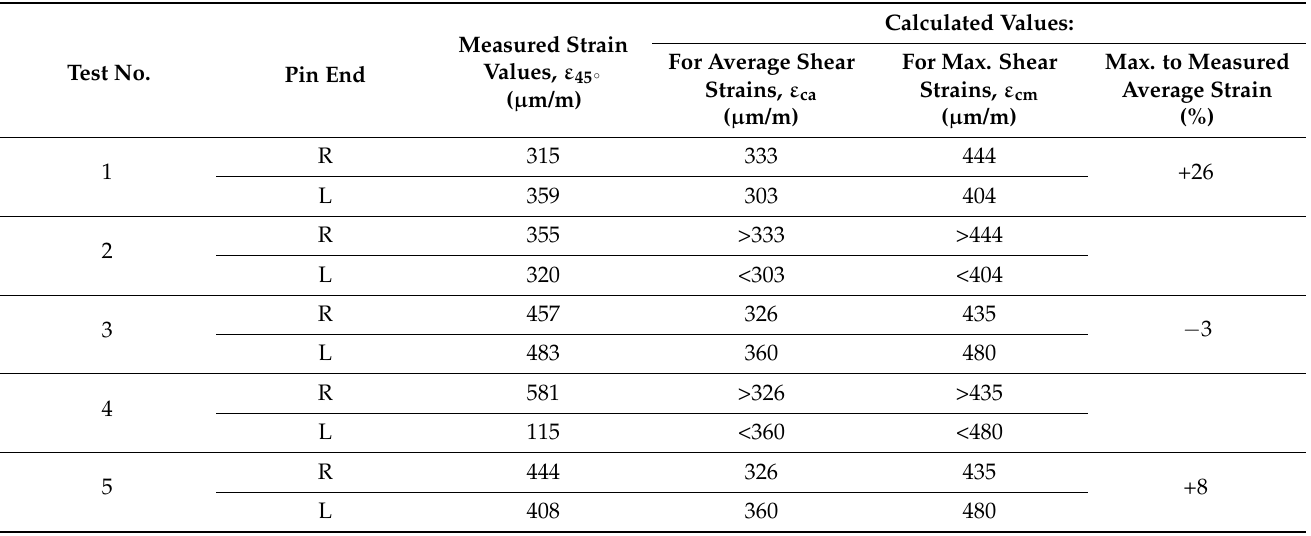
Table 3. Measured and calculated strain values at real cross-sections for 0 ◦ pin rotation and 500 kN external load.